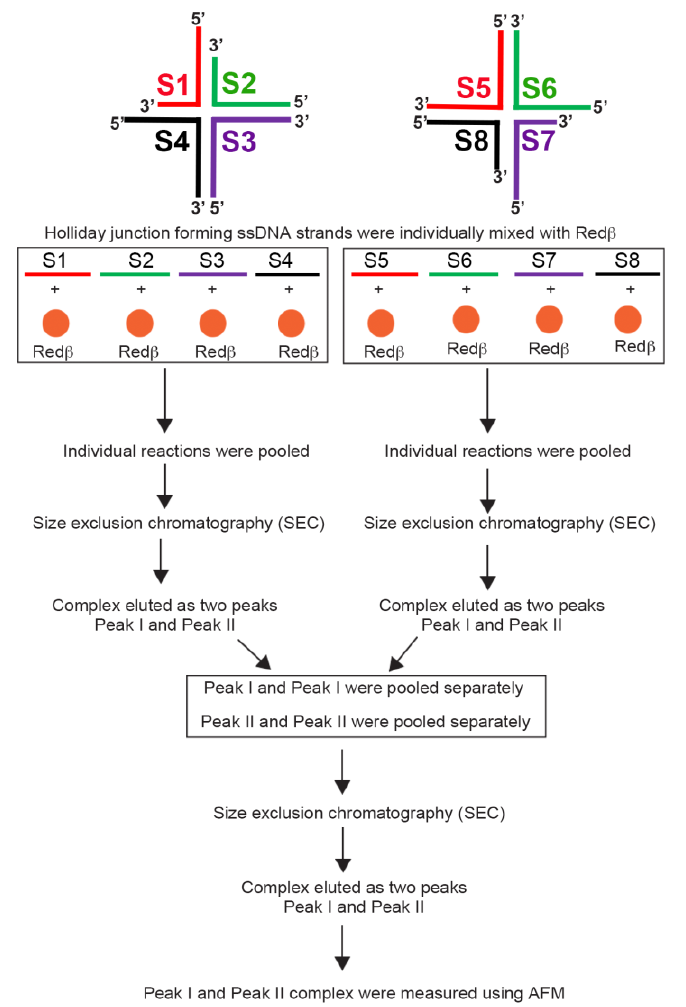
Figure 5. Experimental strategy for species enrichment of S1S4 and S5S8 HJ structures and purification of final hierarchical assemblies using SEC.